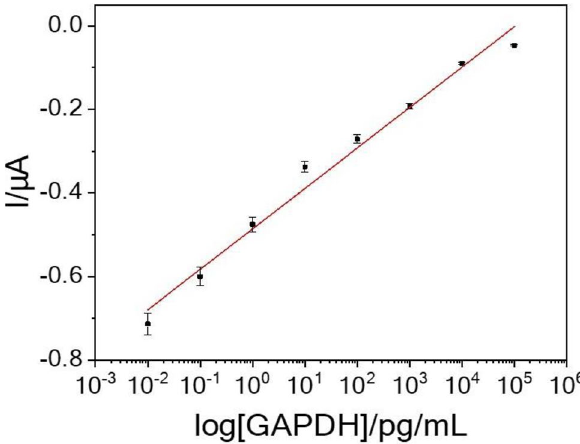
Figure 4. Calibration plot using the stripping-current response.